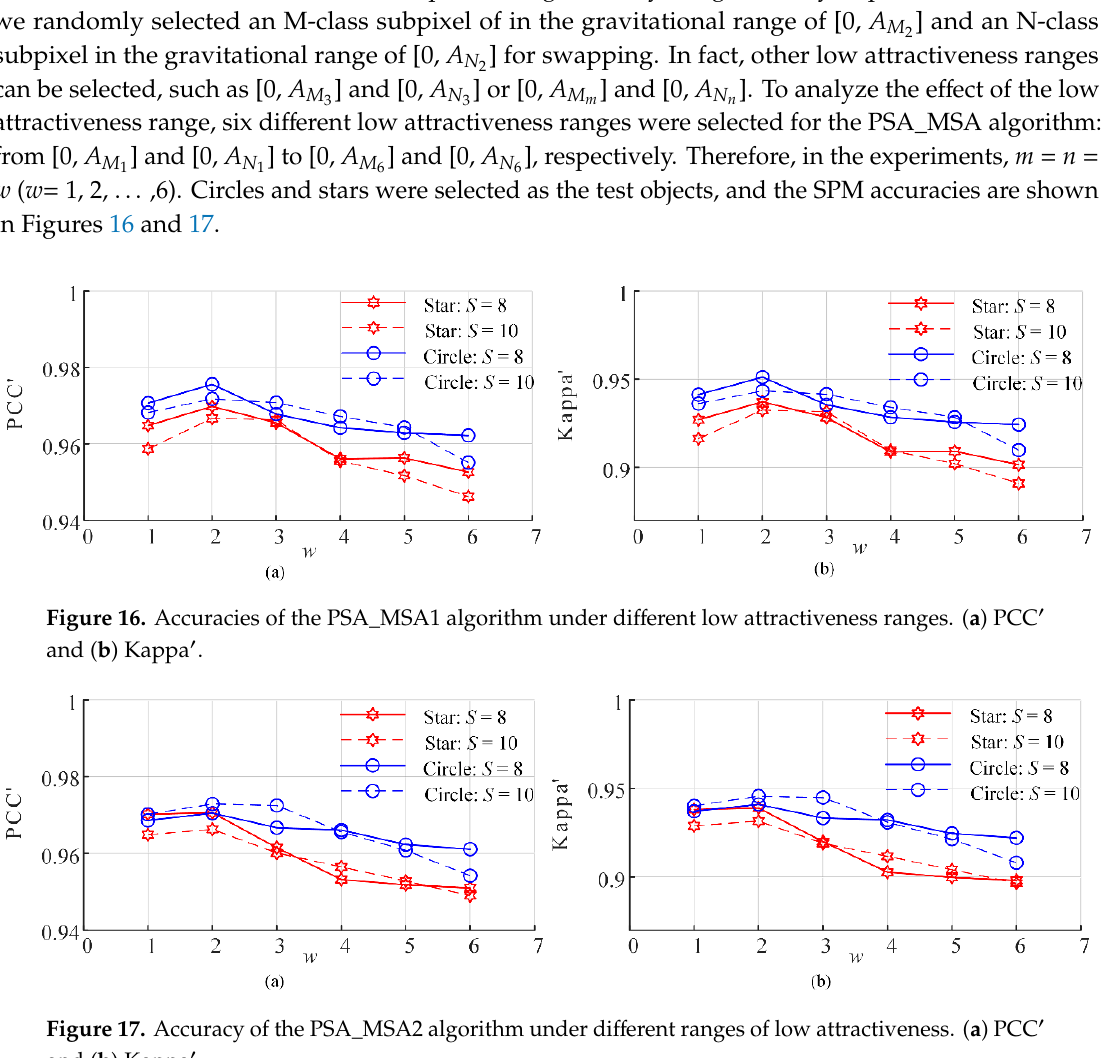
Table 12. Accuracies (%) of two optimization methods for the PSA_MSA2 algorithm.